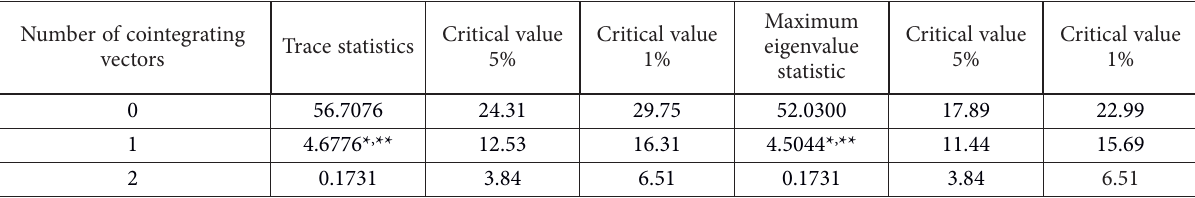
Table A2. Johansen test results for variables from the long-term equation of the symmetric model (source: own study) Number of cointegrating Trace vectors